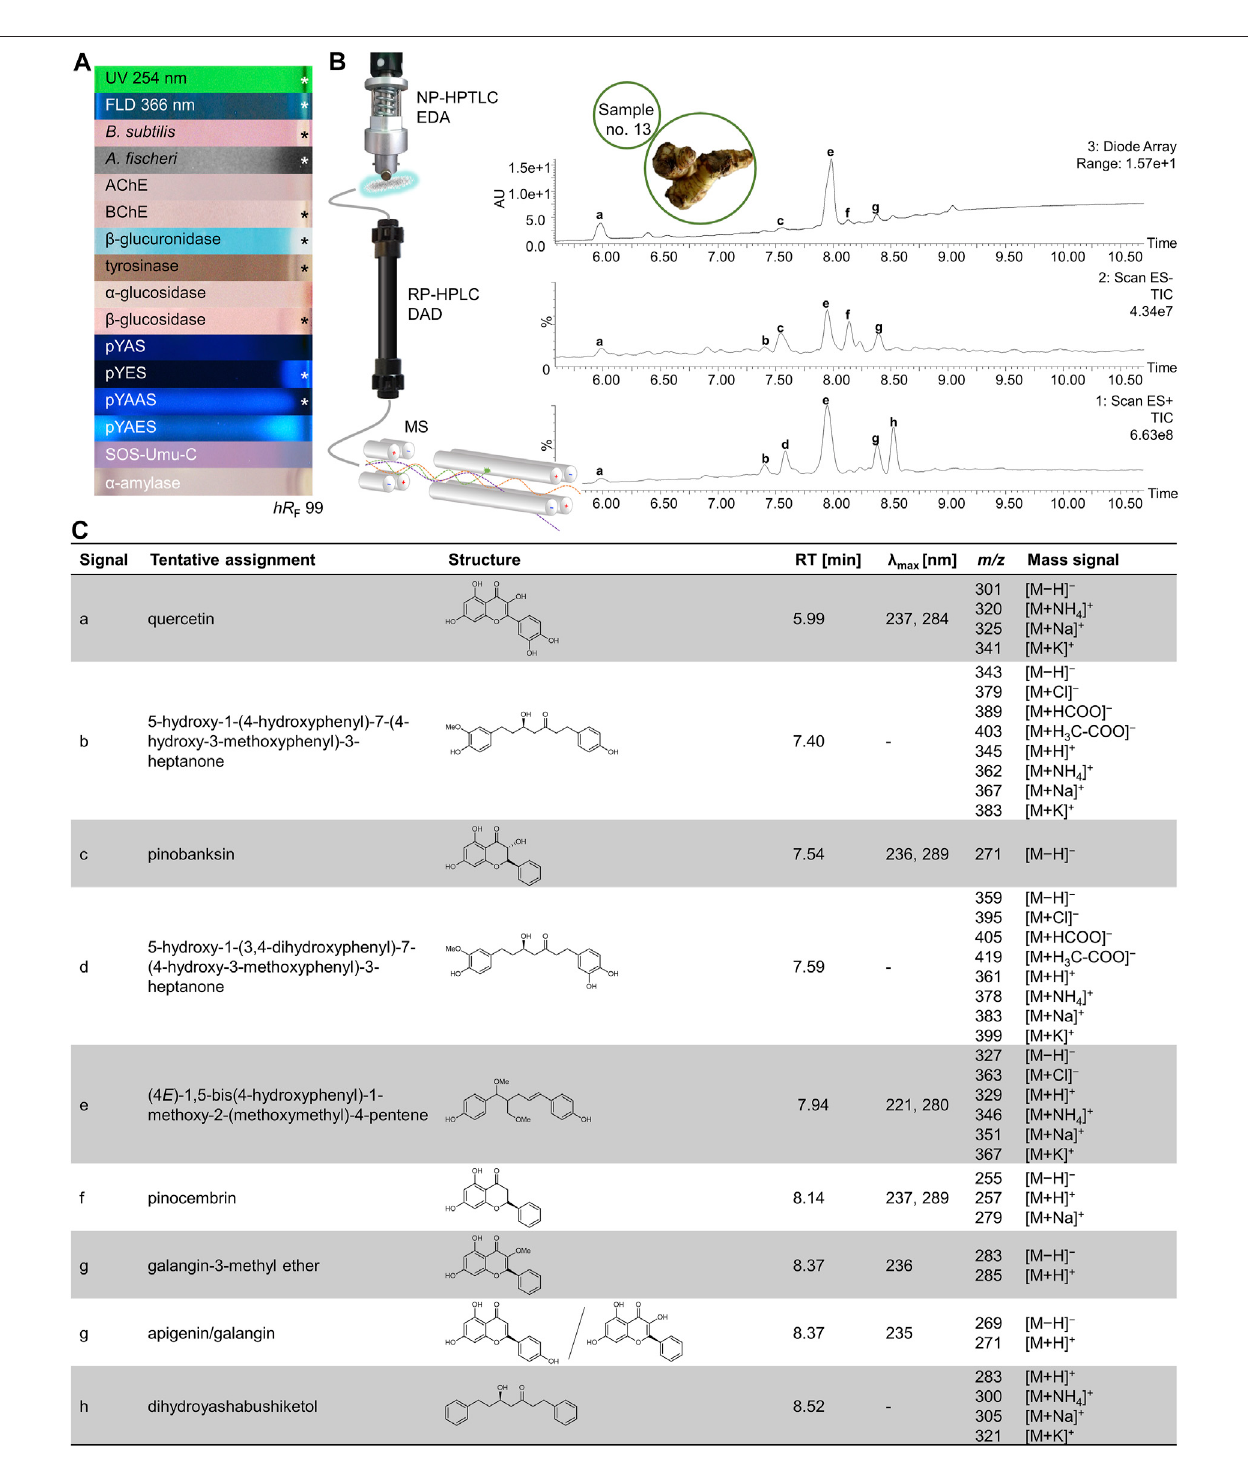
FIGURE 9 | NP-HPTLC − UV/Vis/FLD − EDA − heart-cut RP-HPLC − DAD − HESI-MS analysis of galangal no. 13. NP-HPTLC − UV/Vis/FLD − EDA analysis as in Figure 2 (A) , followed by heart-cut elution of the bioactive zone at hR F 99 (marked*) directly out of the BChE autogram and online desalting to obtain the RP- HPLC − DAD − HESI-MS chromatograms (B) and respective UV and mass spectral data of the peaks a − h (C) .